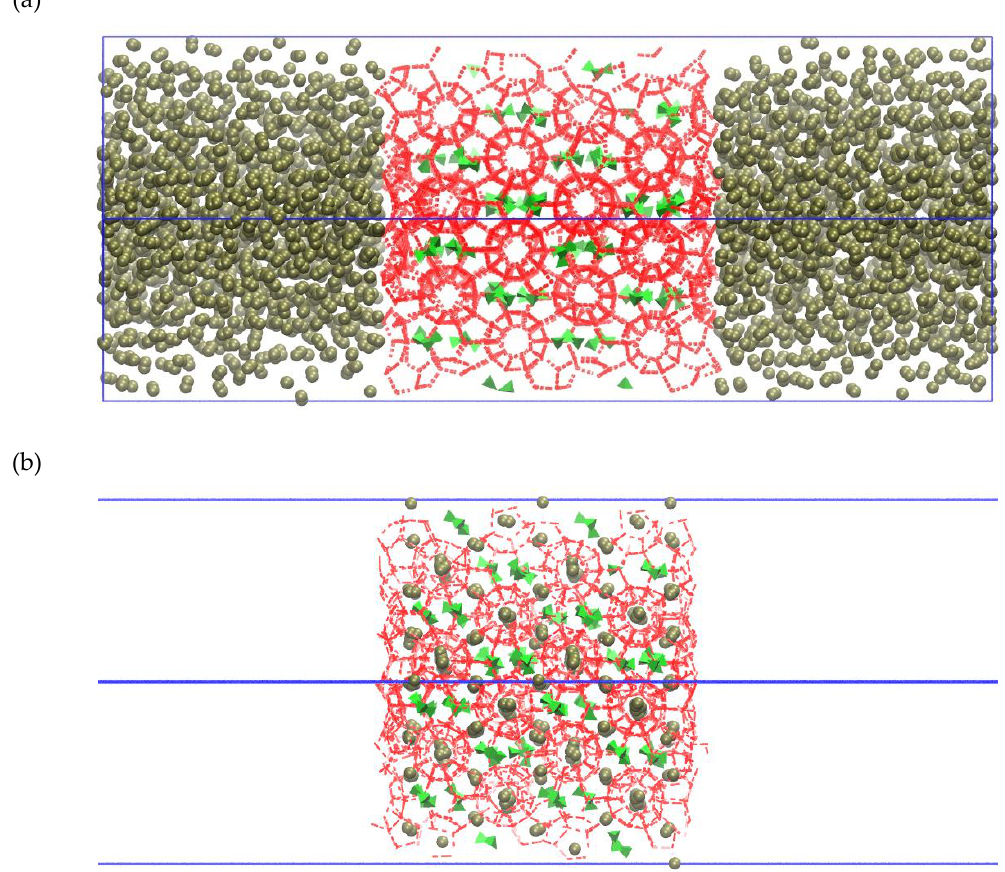
Figure 1. Illustration of two proposed models of propane / hydrogen hydrate uptake ( a ) and release ( b ) In this representation, each tri-group of light green octahedra denotes a propane molecule and olive-coloured spheres depict the hydrogen molecule position. Red dashed lines represent the hydrogen bond between water molecules.